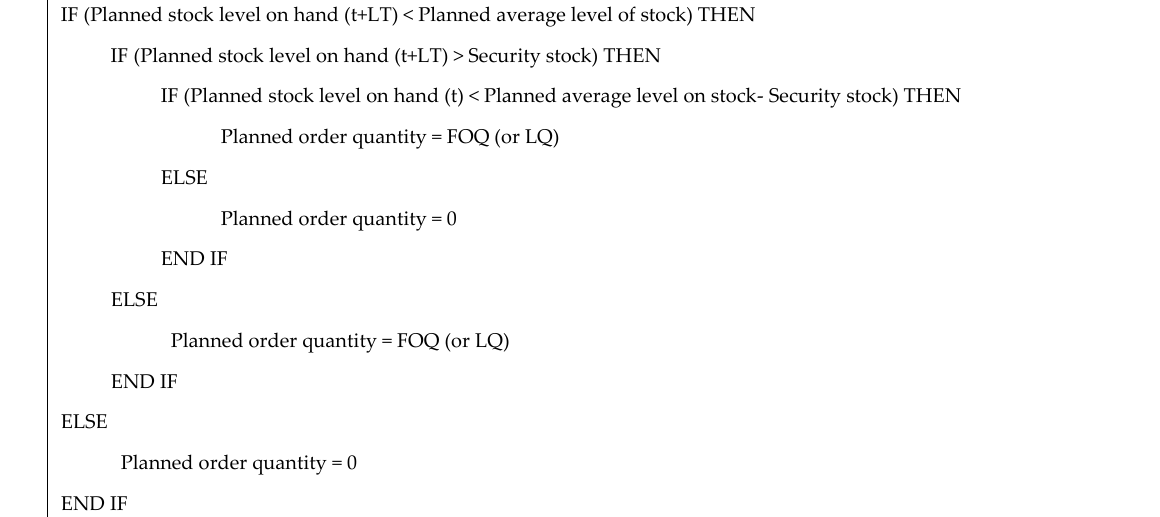
Figure 5. Pseudocode for planned order quantity.